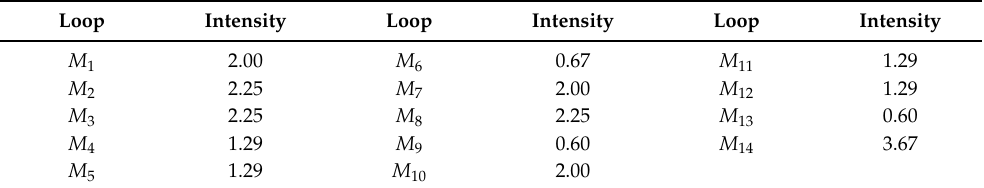
Table 2. Intensities corresponding to the cycles depicted in the diagram of the Figure 4. Every loop in the cycle of time is numbered as V i